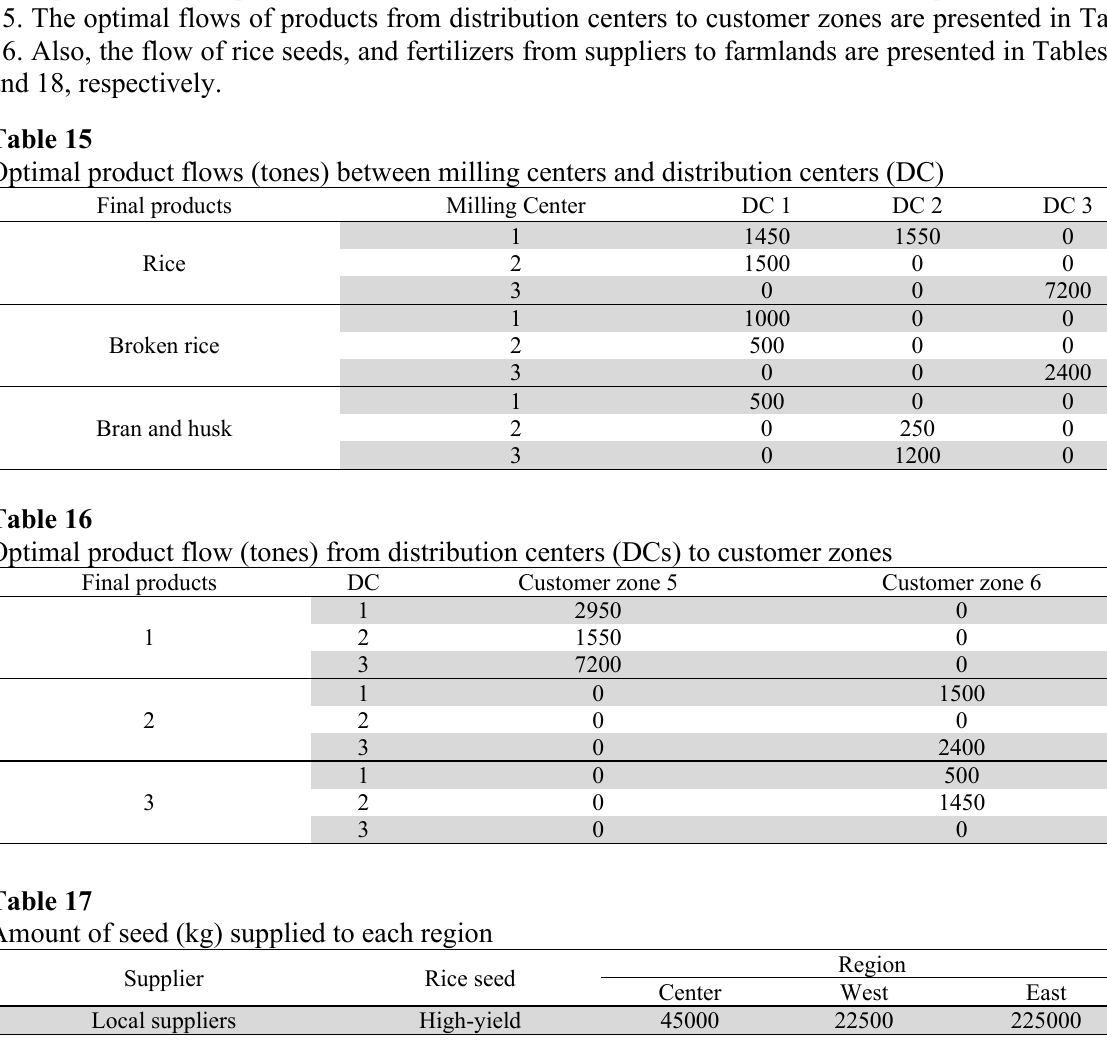
Amount of fertilizer (kg) supplied to each region Region